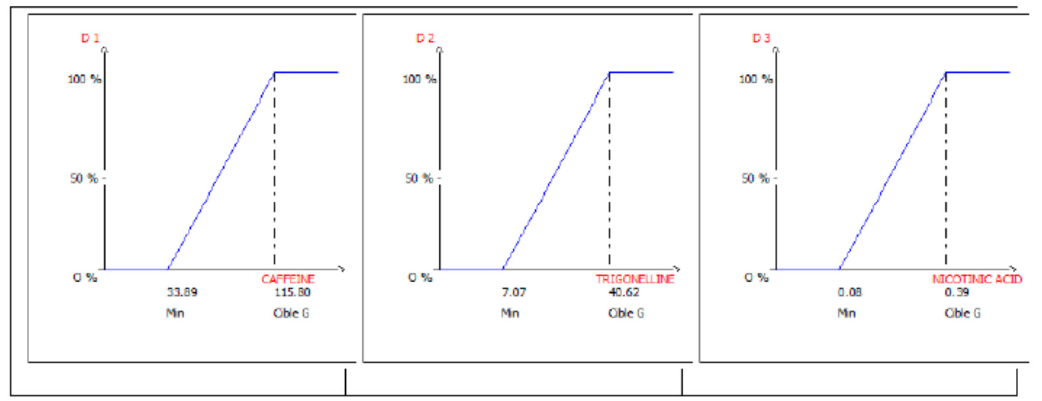
Figure 2. The elementary desirability functions ( d 1 , d 2 and d 3 ) for the maximization of the three response variables Y 1 = caffeine, Y 2 = trigonelline, and Y 3 = nicotinic acid.